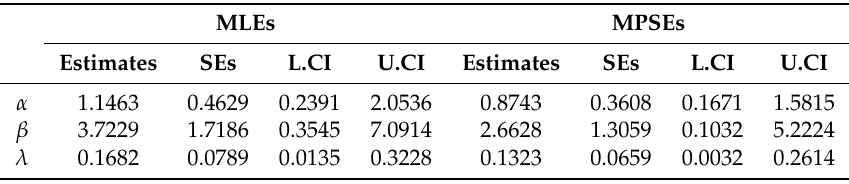
Table 4. Estimates, standard errors (SEs), lower and upper CI (L.CI and U.CI) using the MLE and MPS methods for for complete electric data.